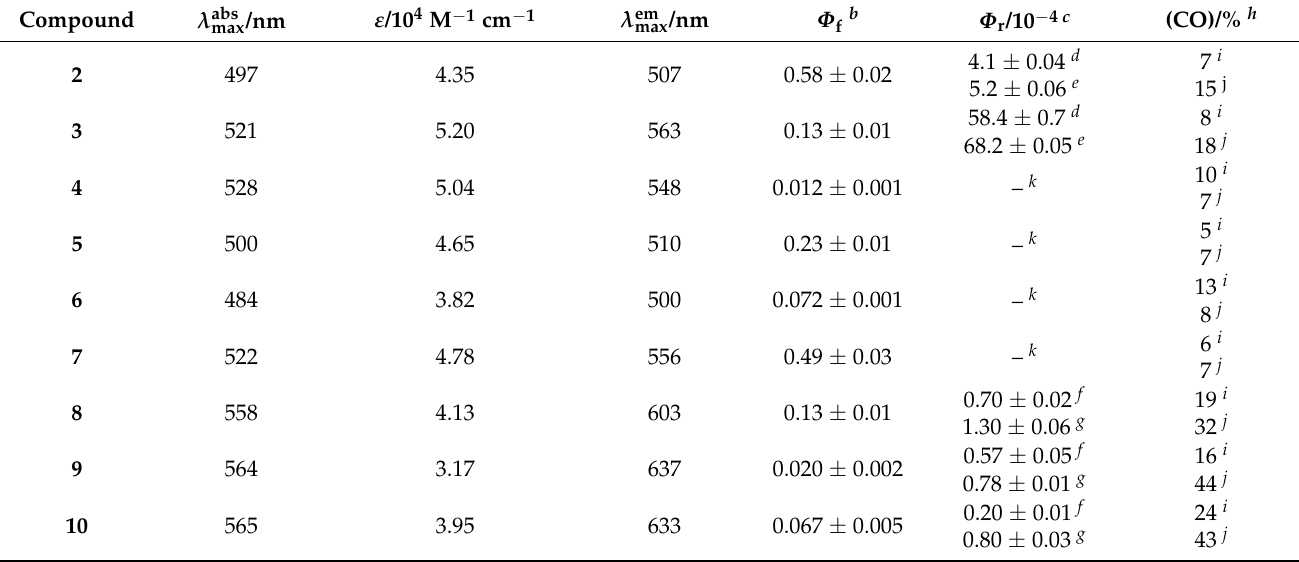
Table 2. Photophysical and photochemical properties of meso -Carboxy BODIPY derivatives in PBS/DMSO mixtures